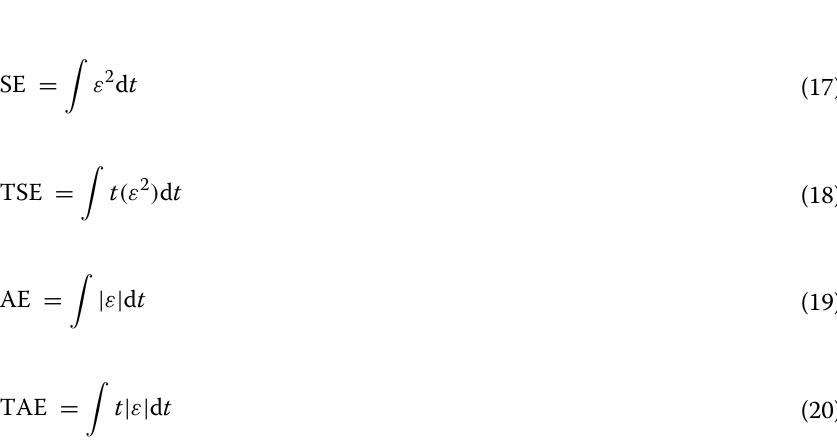
Fig. 16 Variation in pump flow rate for case (1) a PID controller, b NPID controller, c FOPID